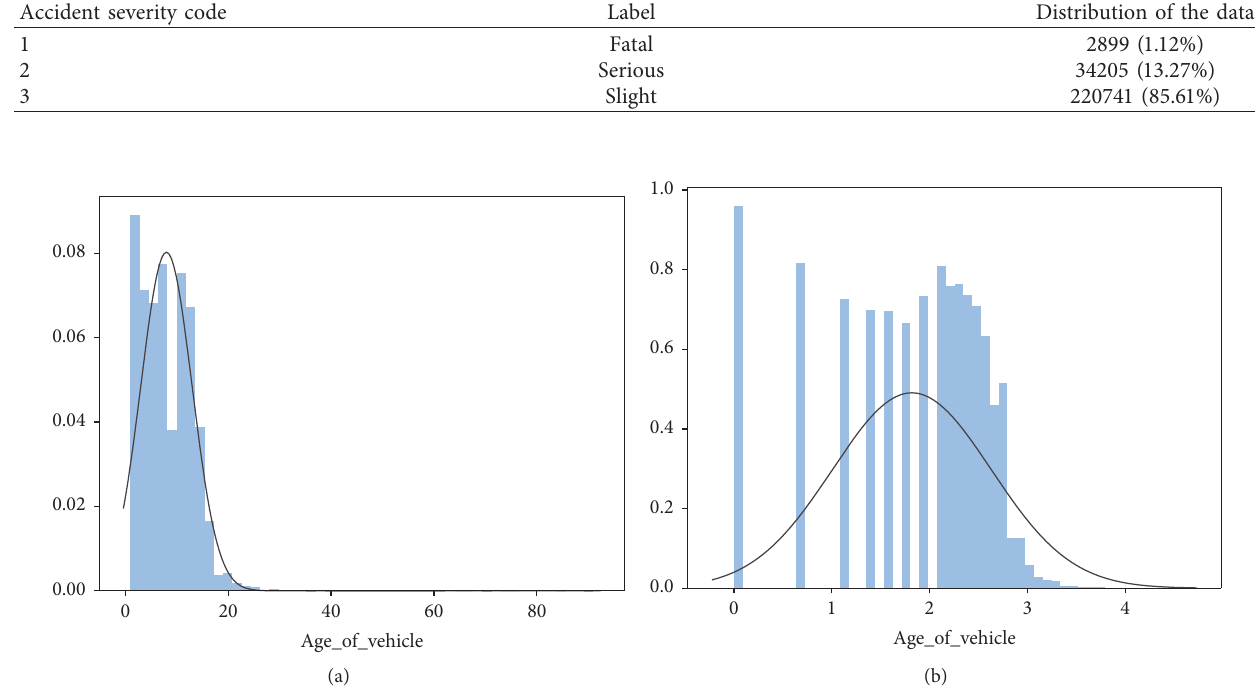
Figure 7: Data distribution (a) before normalization and (b) after